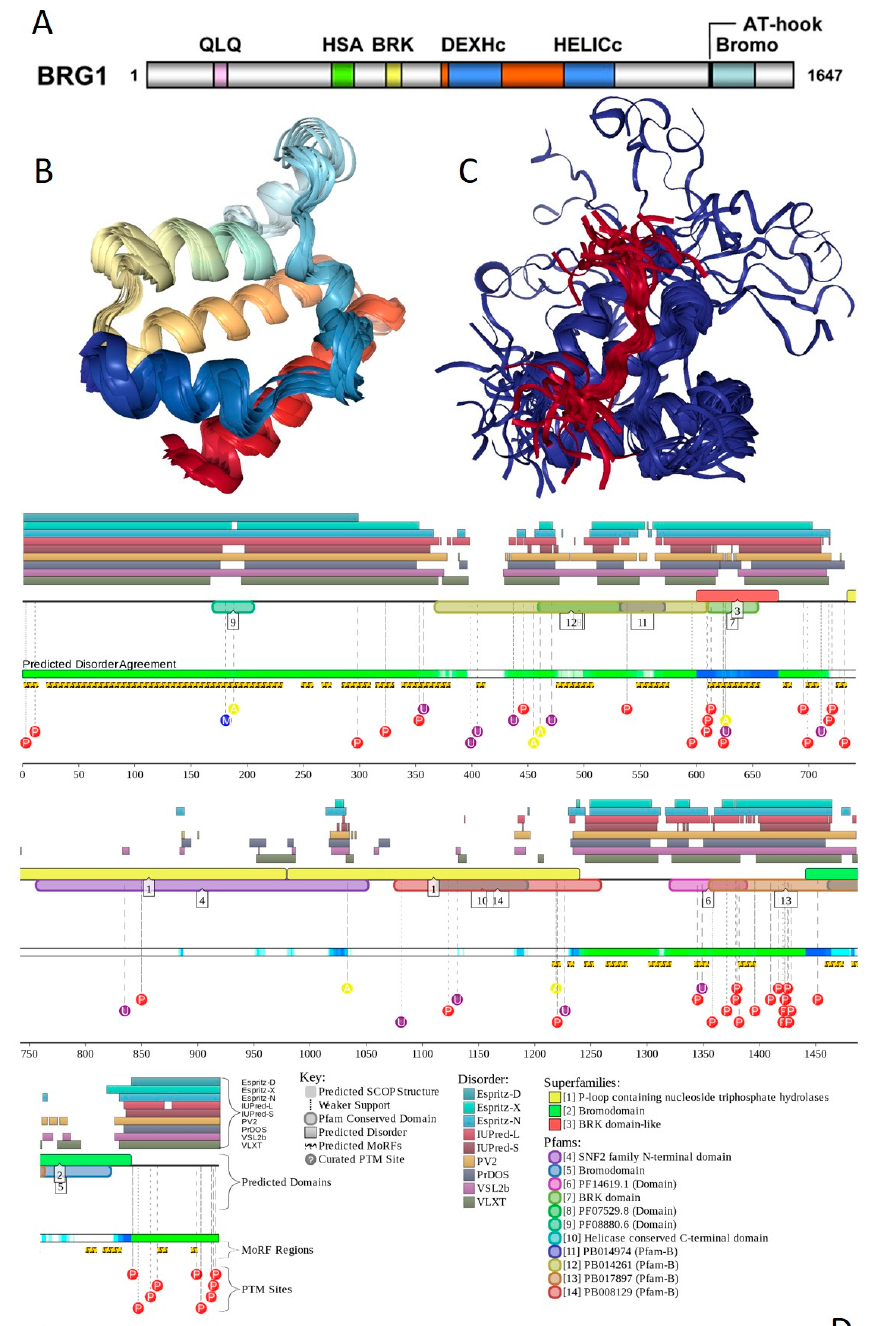
Figure 5. Structural organization of human BRG1 protein. ( A ) Domain architecture of the protein. ( B ) NMR solution structure of the bromodomain (residues 1452–1570, PDB ID: 2H60). ( C ) NMR solution structure of the C-terminal peptide of BRG1 (residues 1591–1602, red structures) bound to the Brd3 ET domain (PDB ID: 6BGH, blue structures). ( D ) D 2 P 2 functional disorder profile of human BRG1 protein (UniProt ID: P51532).